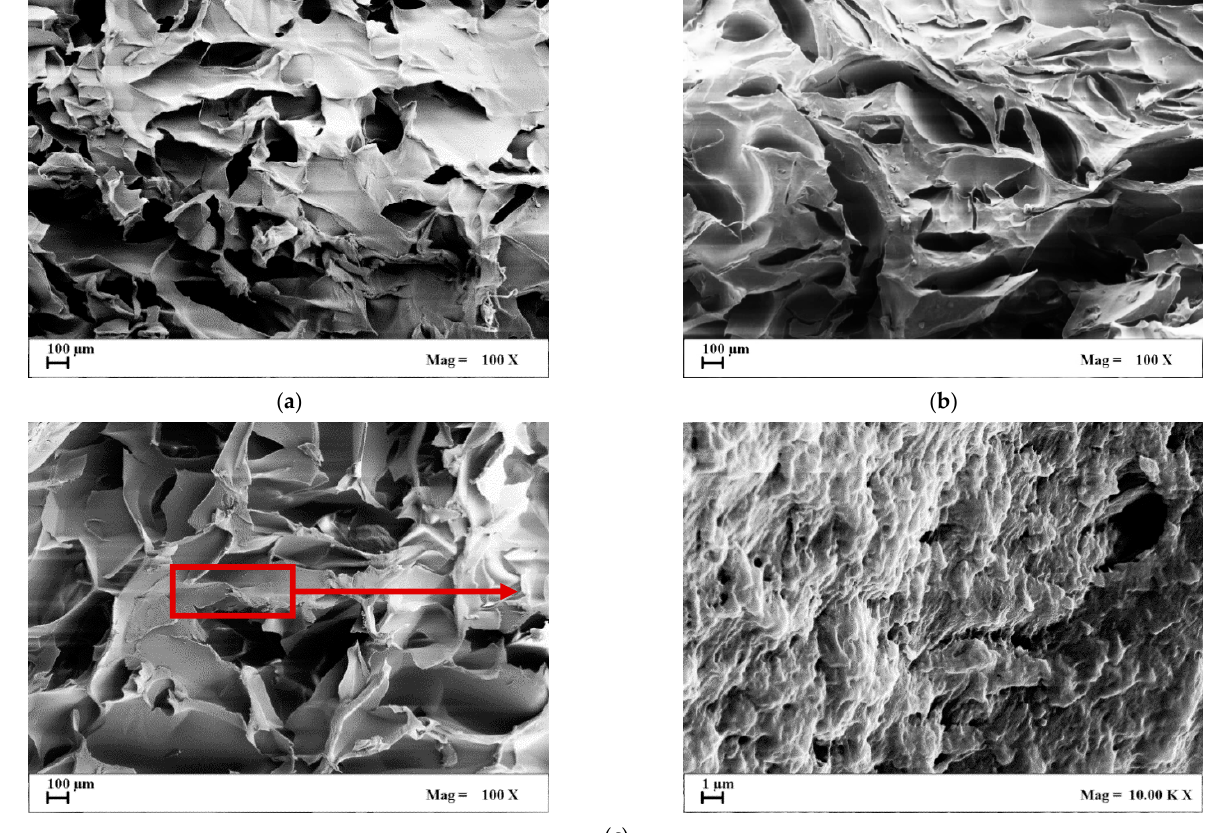
Figure 3. SEM images of cryogels section obtained by a slow ‐ cooling step: ( a ) 3 wt% agarose; ( b ) 5 wt% agarose; ( c ) 8 wt% agarose.